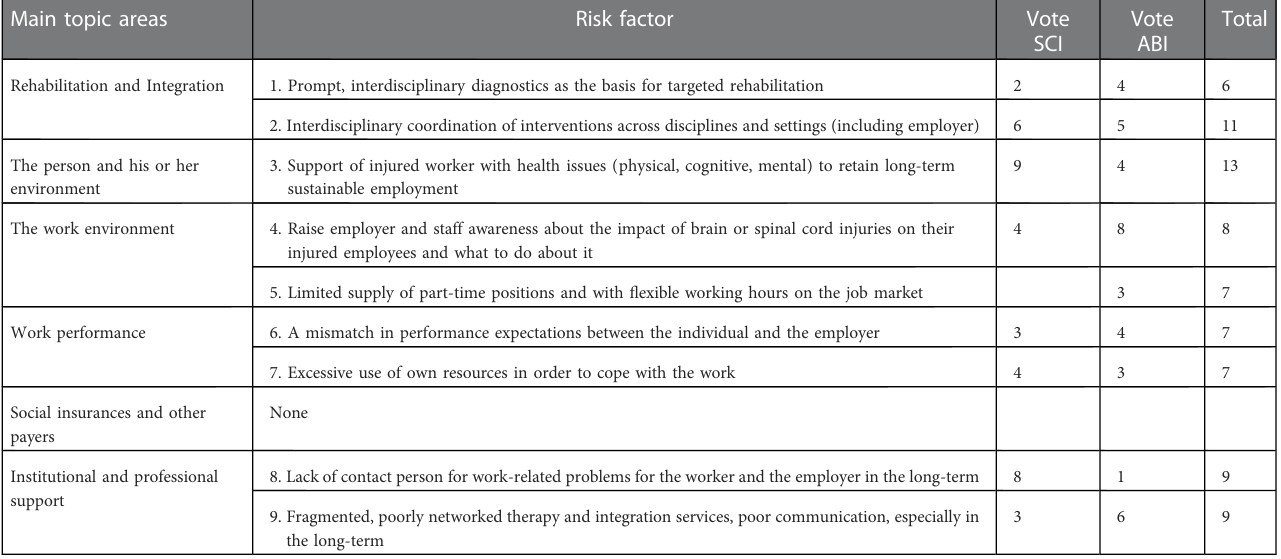
TABLE 2 Risk factors selected during the condition-speci fi c fi rst group